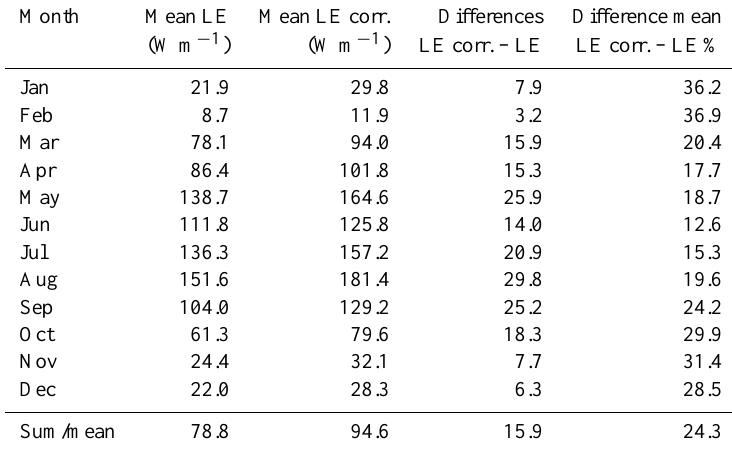
Table 4. Measured mean monthly latent heat fluxes and corrections for EBD for 2012. Month Mean LE Mean LE